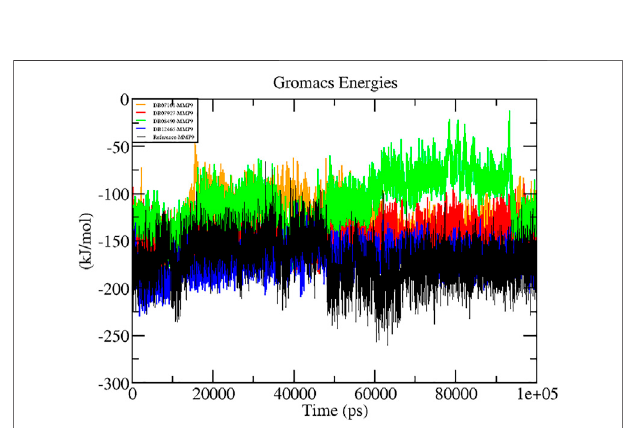
FIGURE7| Graphsrepresentingtheinteractionenergyofprotein – ligand complexes.